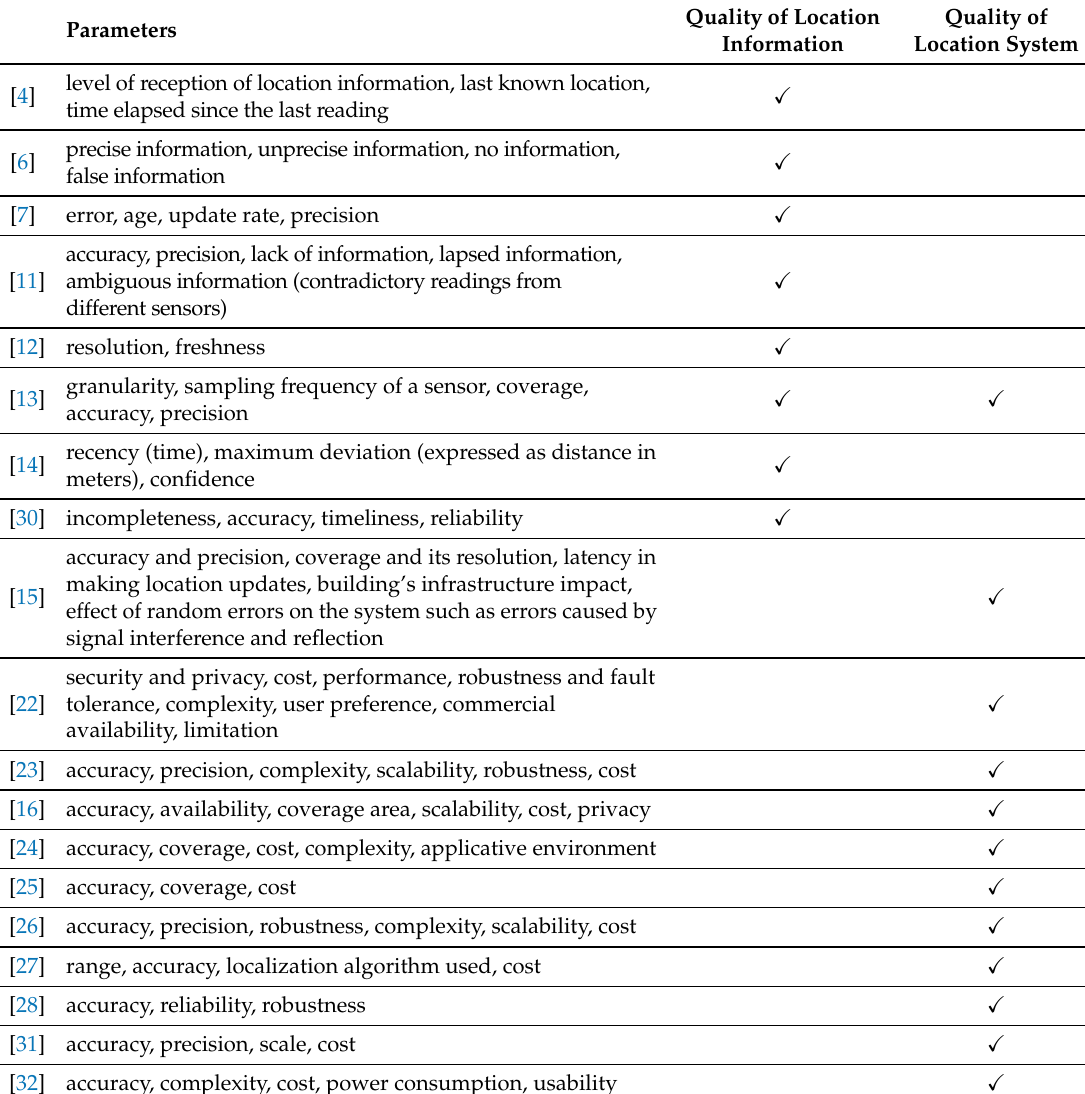
Table 1. Parameters used in literature to describe the quality of location information and the quality of location systems .